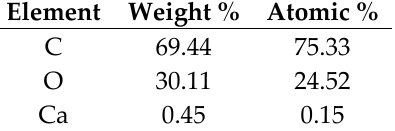
Figure 7. Fourier-transform infrared spectra in the 4000–2100 cm –1 range of untreated and Ca(OH) 2 - treated G. angustifolia samples.